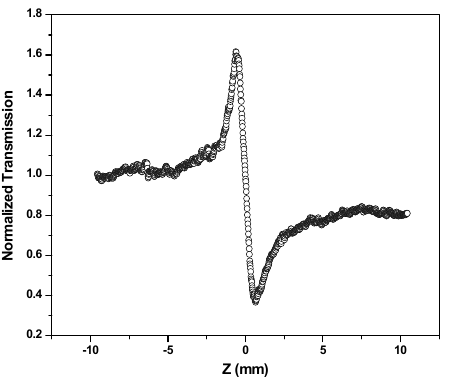
Figure 7. Normalized transmittance (closed aperture) for colloidal AgNPs, S0. The nonlinear refractive index was calculated from the peak–valley differences of the normalized z-scan curve. The difference between the peak–valley of the normalized transmittance z-scan ( ∆ T p − v ) is given by,